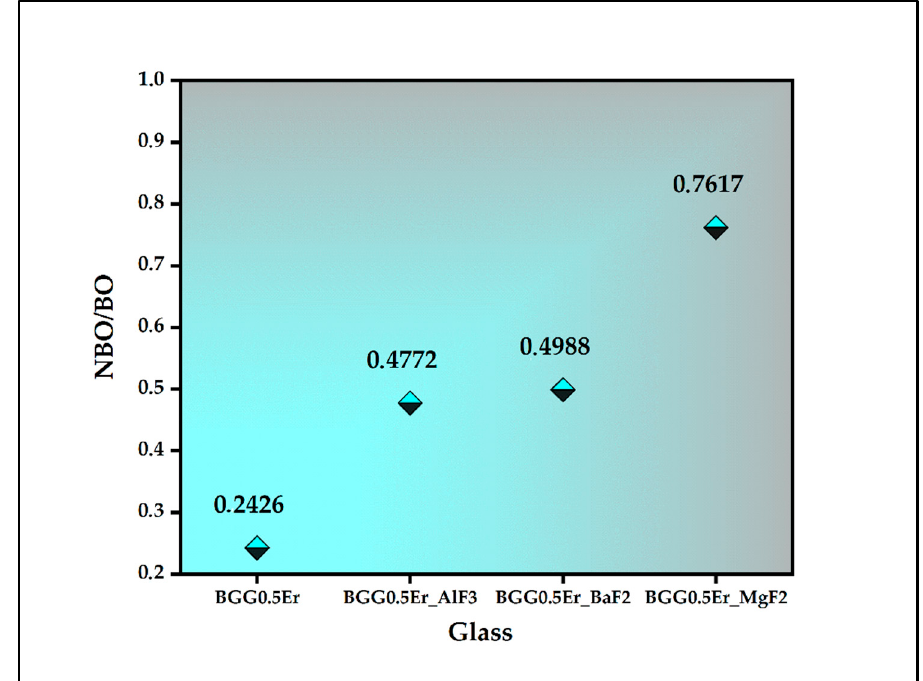
Figure 8. The ratio of the NBO/BO. Table 2. Assignment of the IR